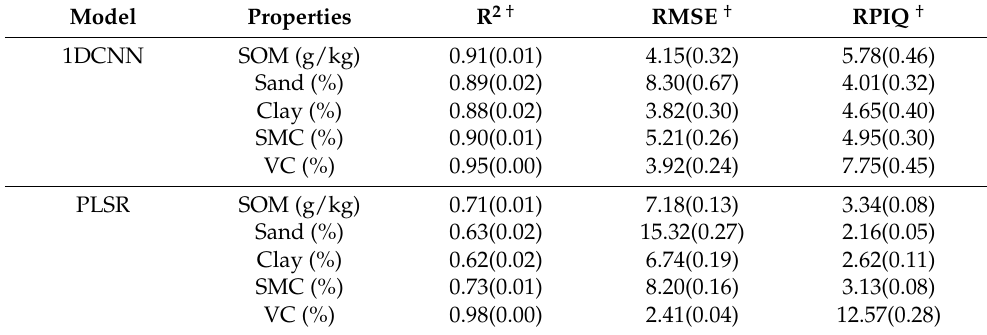
Table 3. The average prediction results of 20 randomly divided test sets using different models.